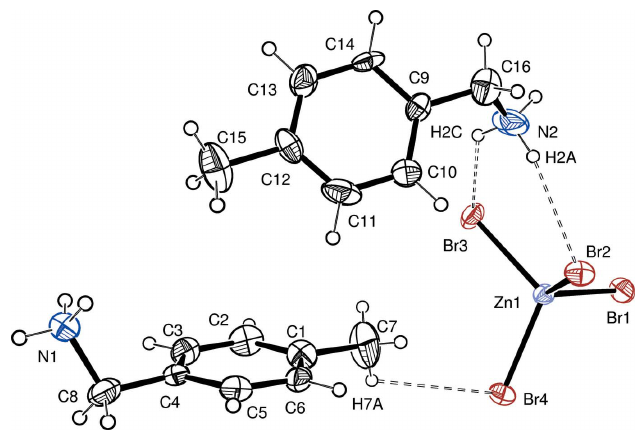
Figure 1 A view of the asymmetric unit, showing the atom numbering and displacement ellipsoids drawn at the 30% probability level. Dashed lines indicate hydrogen-bonding Fig. 1. The Zn 2+ cation is tetrahedrally coordinated by four bromide ligands with Zn—Br bond lengths ranging from 2.399 (3) to 2.426 (3) A˚ , and Br—Zn—Br bond angles varying between 104.90 (12) and 113.82 (13) (cid:5) . The crystal structure consists of layers of 4-methylbenzyl- ammonium cations sandwiched between tetrabromidozincate layers extending parallel to the ac plane, as shown in Fig. 2.